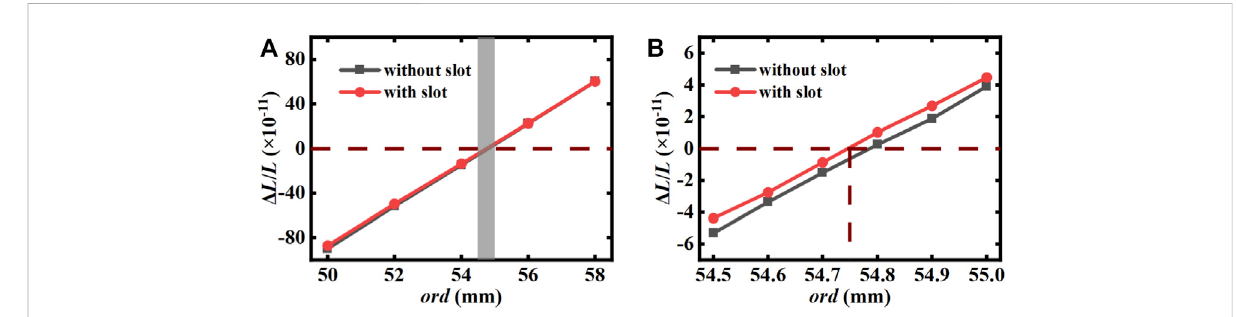
FIGURE 8 EffectofthepresenceorabsenceofasmallslotontherelationshipbetweenO-ringdimensionsandtherelativeaxialdeformationofthemirror center. (B) Is an enlarged view of the shaded part in (A)